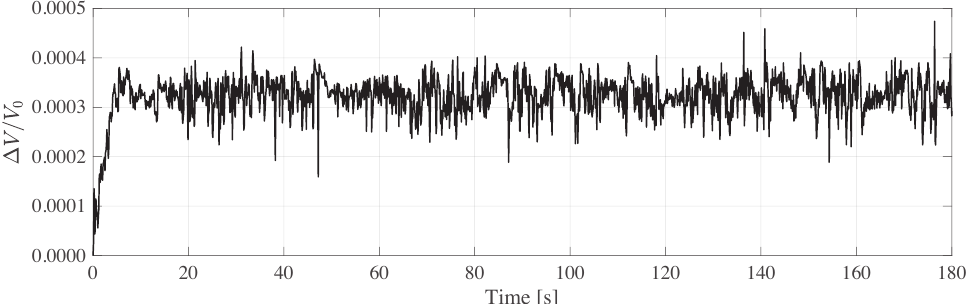
Figure 5. Variation of voltage during the electrical tests showing rapid reach of electrical steady state with no